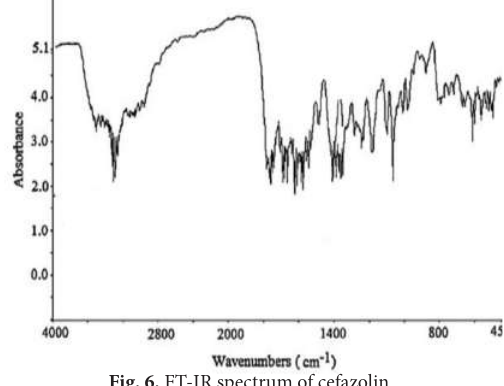
Fig. 6. FT-IR spectrum of cefazolin